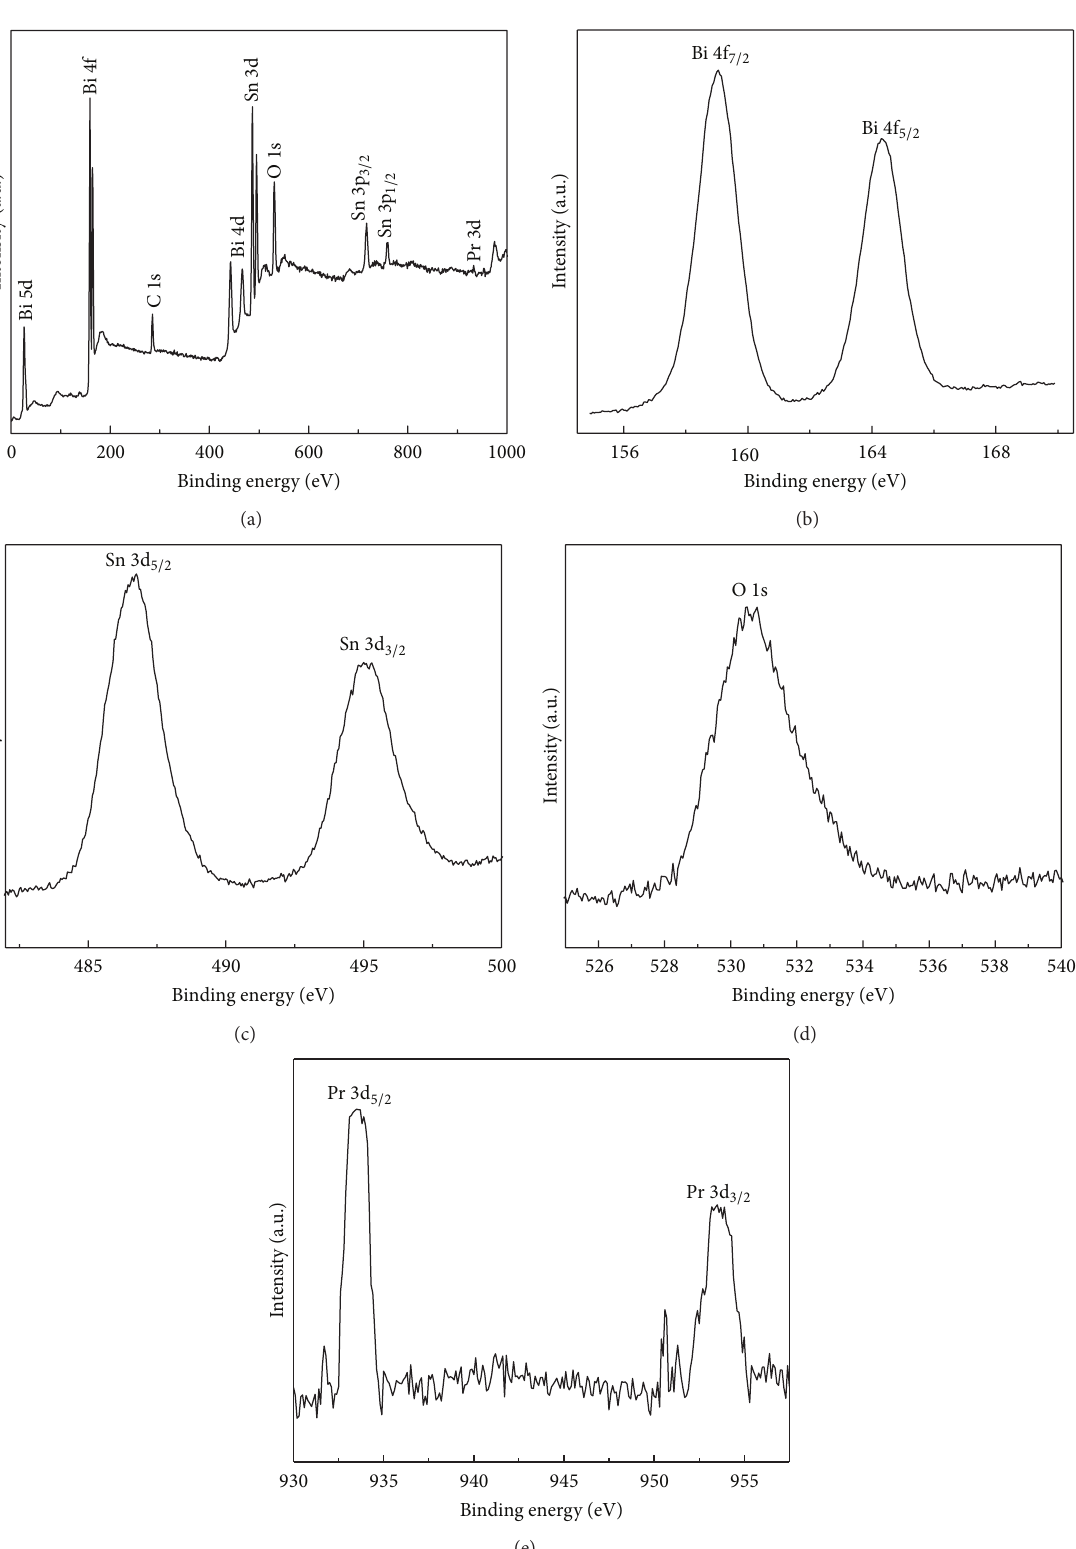
Figure 5: XPS spectra of 1%-Pr-BSO sample: (a) survey spectrum, (b) Bi 4f, (c) Sn 3d, (d) O 1s, and (e) Pr